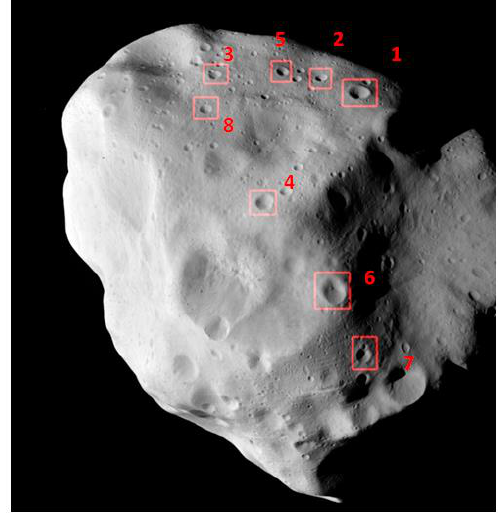
Figure 4. Location of craters subjected to automatic analysis of spatial parameters determination (MPS/UPD/LAM/IAA/RSSD/INTA/UPM/DASP/IDA)